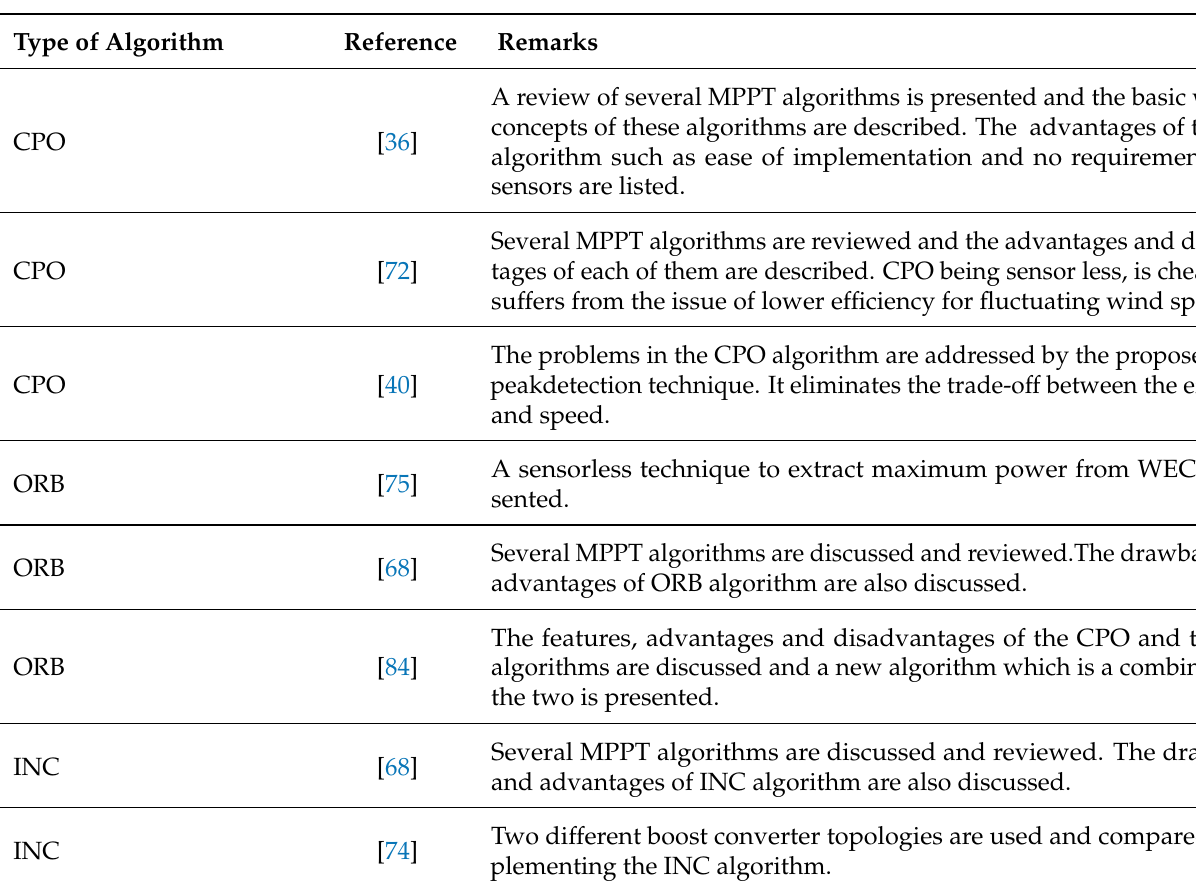
Table 4. Summary of references for DPC based MPPT